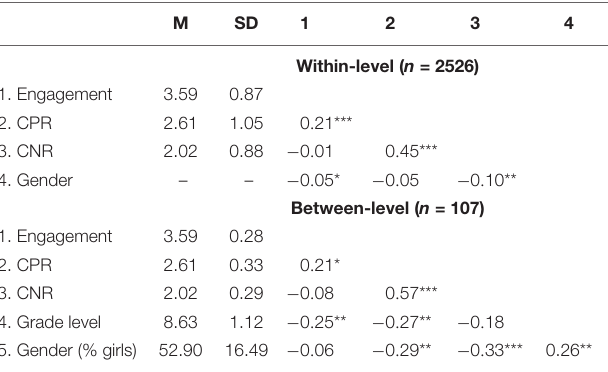
TABLE 1 | Descriptive statistics and correlations between the research variables.